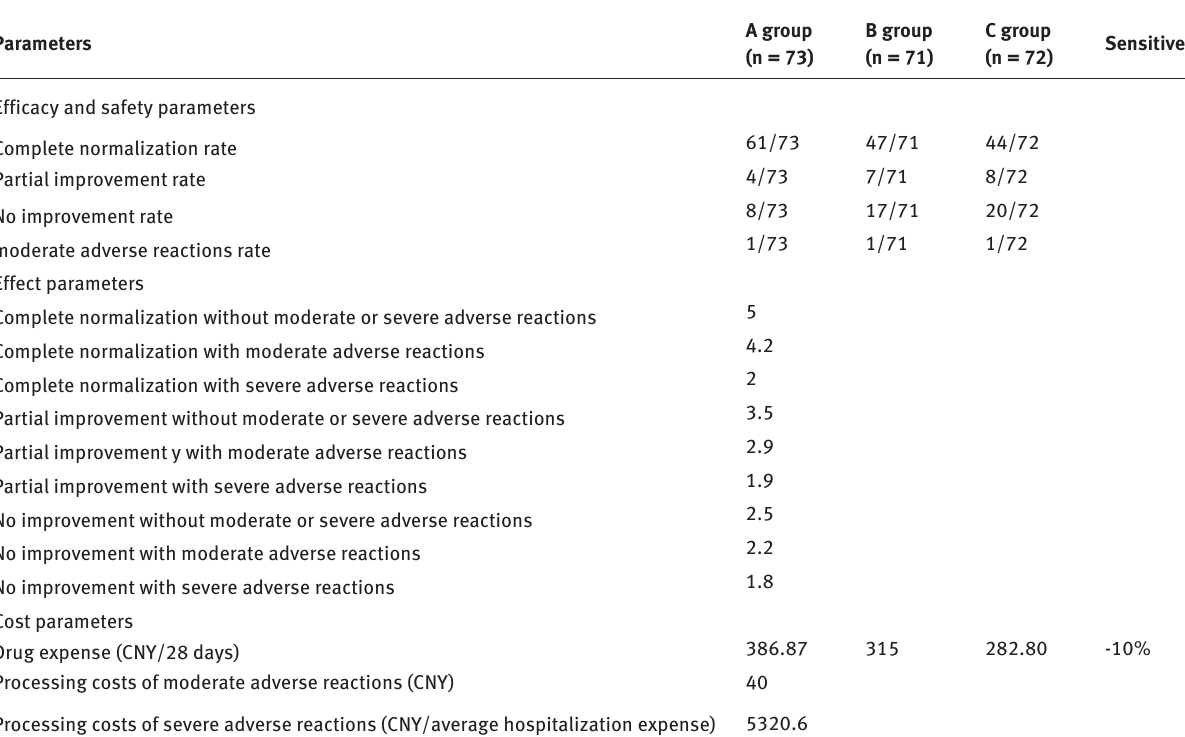
Table 3: Parameters used in the decision tree model